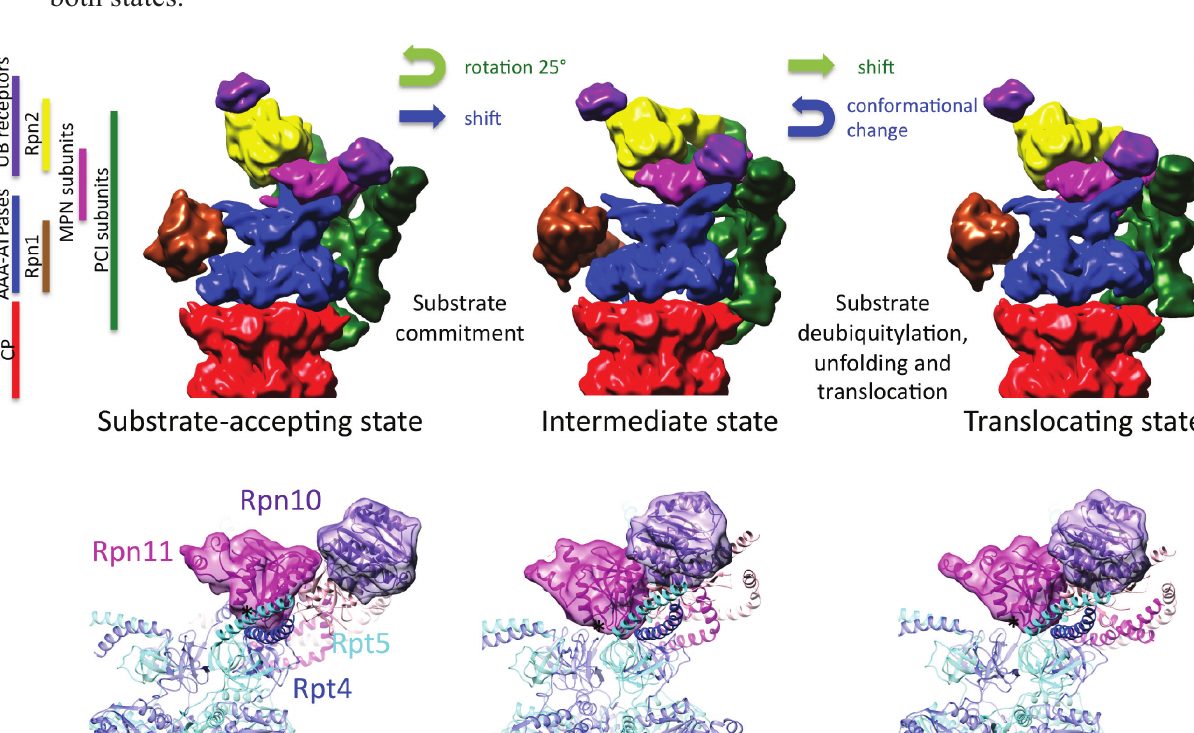
Figure 1. Conformational states of the 26S proteasome. ( Top row ) The S . cerevisiae 26S proteasome has been imaged in three distinct conformational states using cryo-EM single particle analysis [52]. The EM densities are segmented according to their main functional modules indicated in the legend. Upon transition from the low-energy conformation ( left ) to the intermediate conformation ( center ), the non-ATPases rotate en bloc by approximately 25°, and the ATPase module shifts by approximately 5 Å. The ATPases undergo a large-scale conformational change during the transition of the 26S proteasome from the intermediate to the high-energy conformation ( right ) concomitant with a shift of the non-ATPases. The hypothesized functions of the states are substrate recruitment (low-energy), substrate commitment (intermediate) and substrate translocation into the core particle (CP, high-energy). ( Bottom row ) Among the three states, the local environment of Rpn11 is essentially identical in the intermediate and translocating state, suggesting that the enzyme is active in both